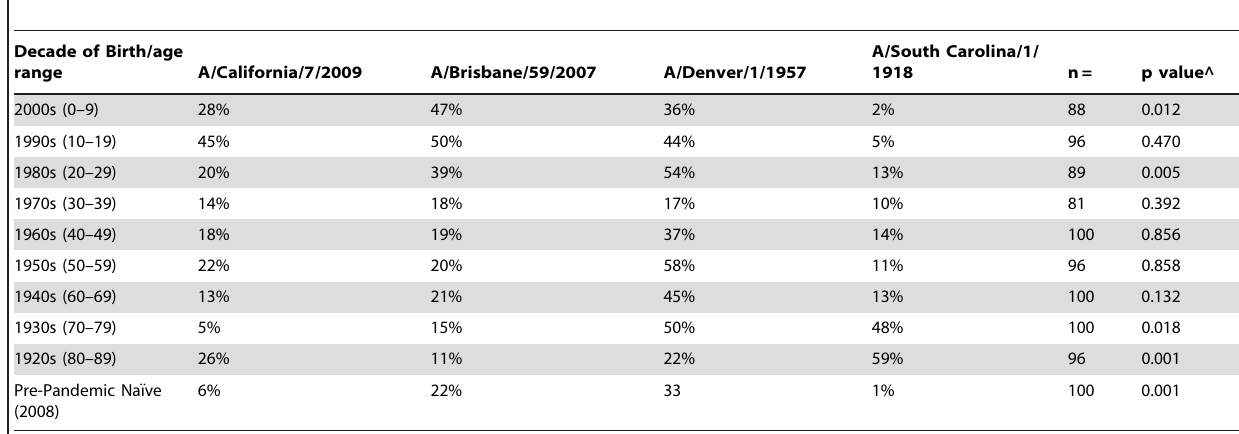
Table 1. Percentage of blood samples positive for influenza antibody by decade of birth and by selected influenza strains.